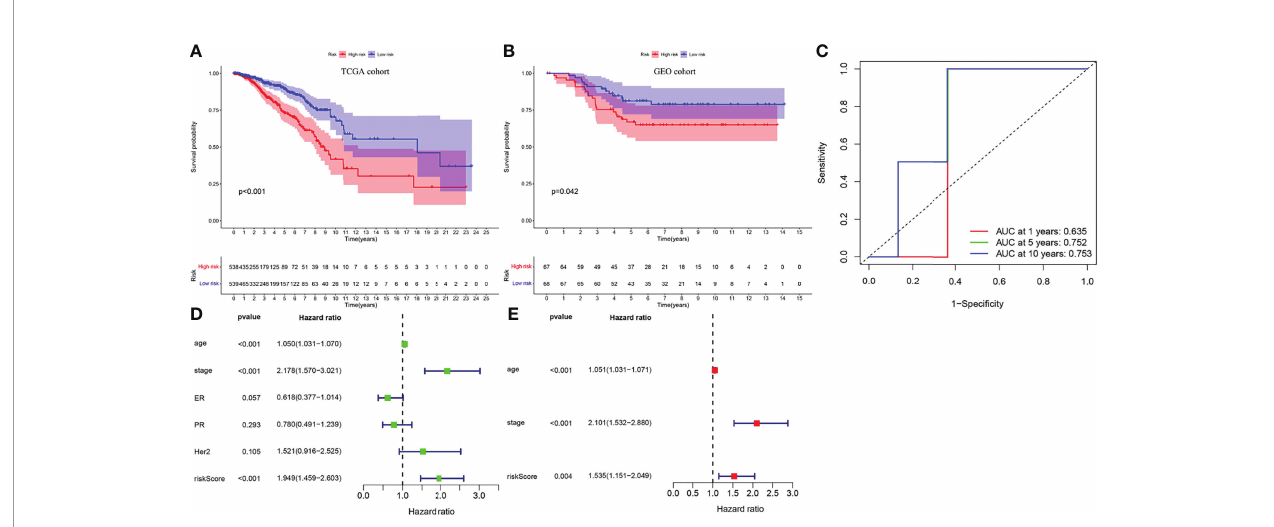
FIGURE 4 | The veri fi cation of IRGPI. (A) Survival curves of BC patients with high-IRGPI and low-IRGPI subgroups in TCGA cohort. (B) Survival curves of BC patients with high-IRGPI and low-IRGPI subgroups in GEO cohort. (C) The IRGPI 1, 5and 10 years area under curve (AUC). (D) IRGPI univariate COX regression